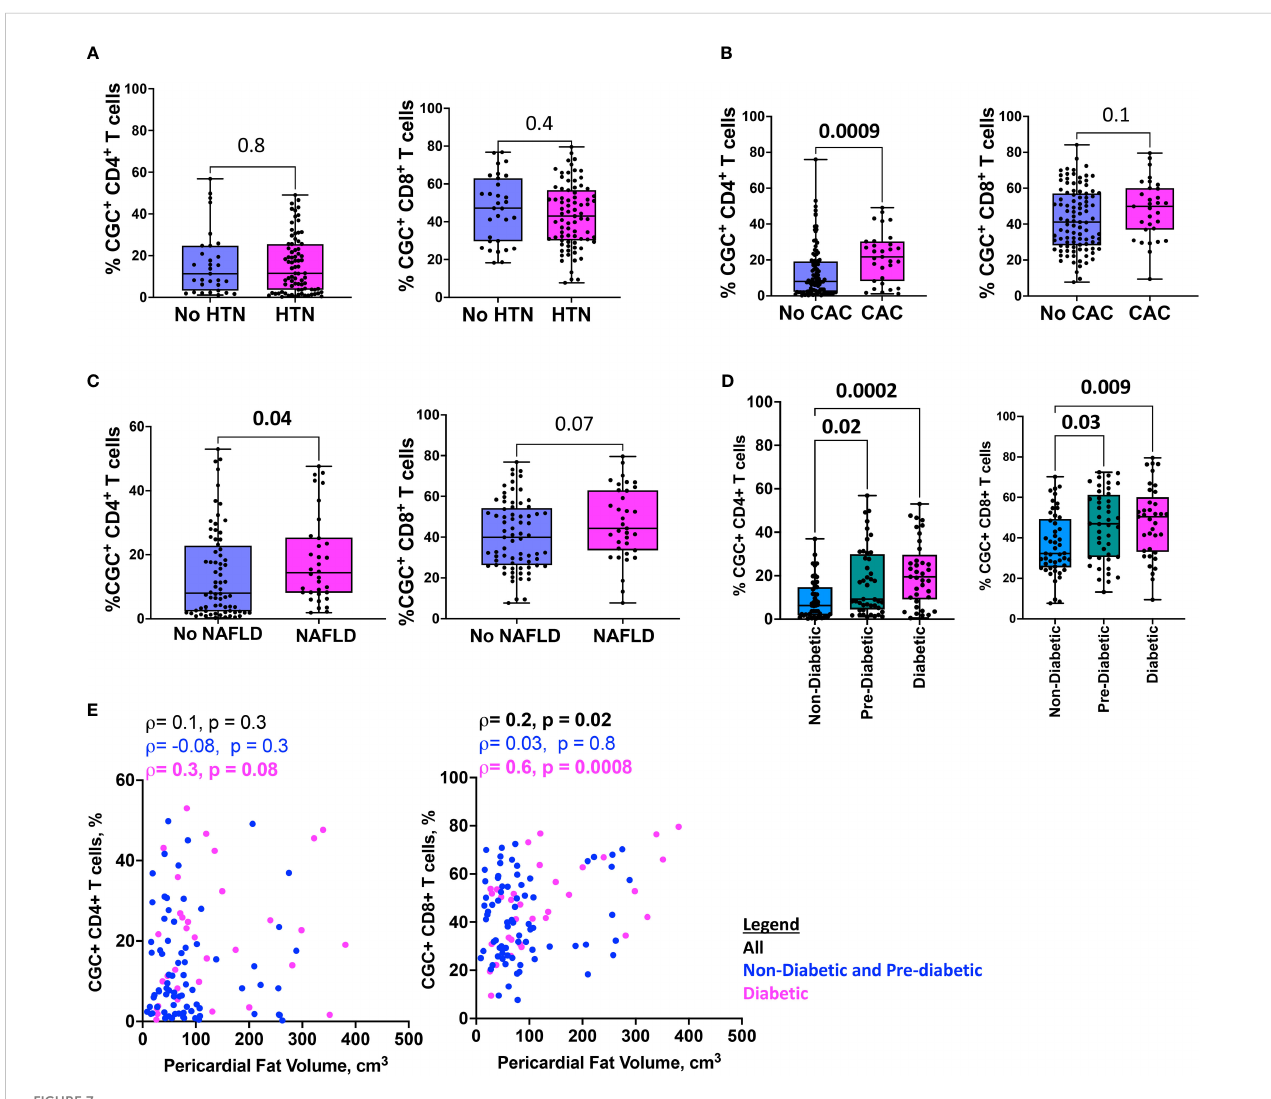
FIGURE 7 HIgher CGC + CD4 + T cells are associated with cardiometabolic disease. Box plots showing CGC + CD4 + and CGC + CD8 + T cells in the presence or absence of hypertension (HTN) (A) , coronary arterial calcium (CAC) (B) , non-alcoholic fatty liver disease (NAFLD) (C) , and diabetes (D) . Correlation plots show the relationship between CGC + T cells and pericardial fat volume (E) . Statistical analysis by Mann Whitney, Kruskal Wallis, and Spearman ’ s rank correlation